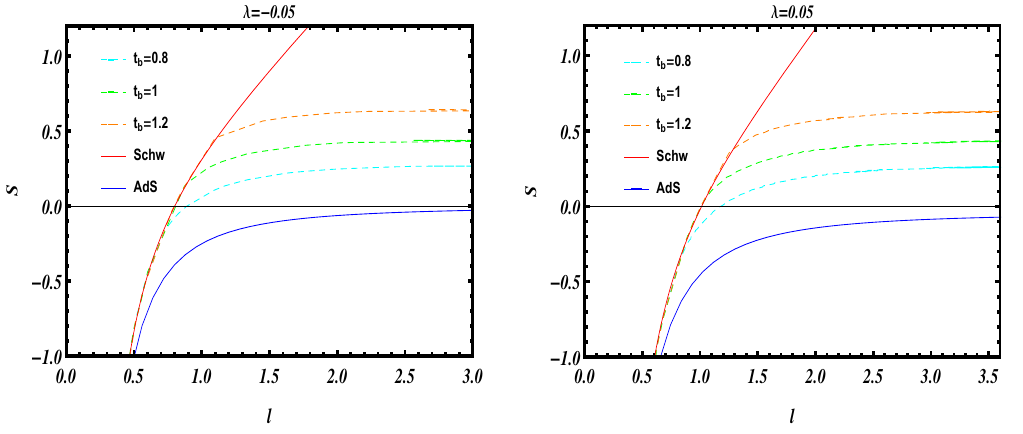
Figure 6 . Left panel: minima for the two families of extremal surfaces M S , red and M 0 , blue. Right panel: their correponding entanglement entropy.